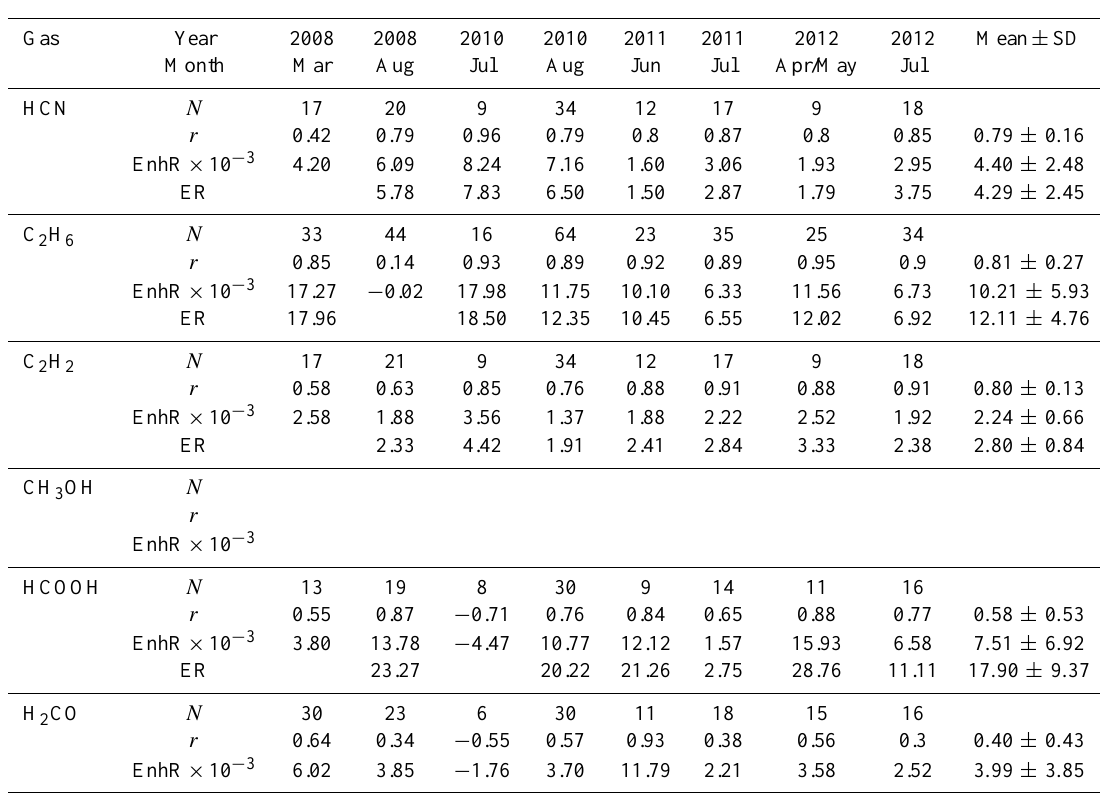
Table 6. Correlation between each trace gas and CO inside the smoke plumes detected over Thule. N is the number of points, r is the coefficient of linear correlation and EnhR are the enhancement ratios, which are the slopes derived from the correlation. For all gases except H 2 CO, ER represents the corrected enhancement ratios from travel time (calculated only if the linear correlation coefficient ( r> 0 . 6)) and the number of points ( N> =